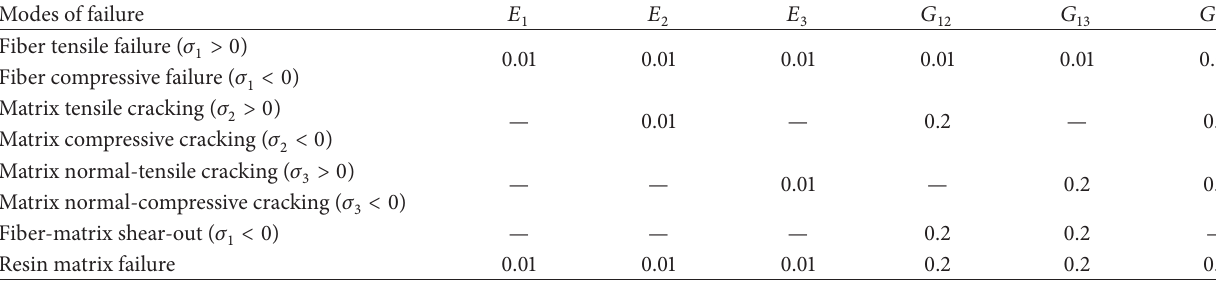
Table 1: Degradation factors of the elastic